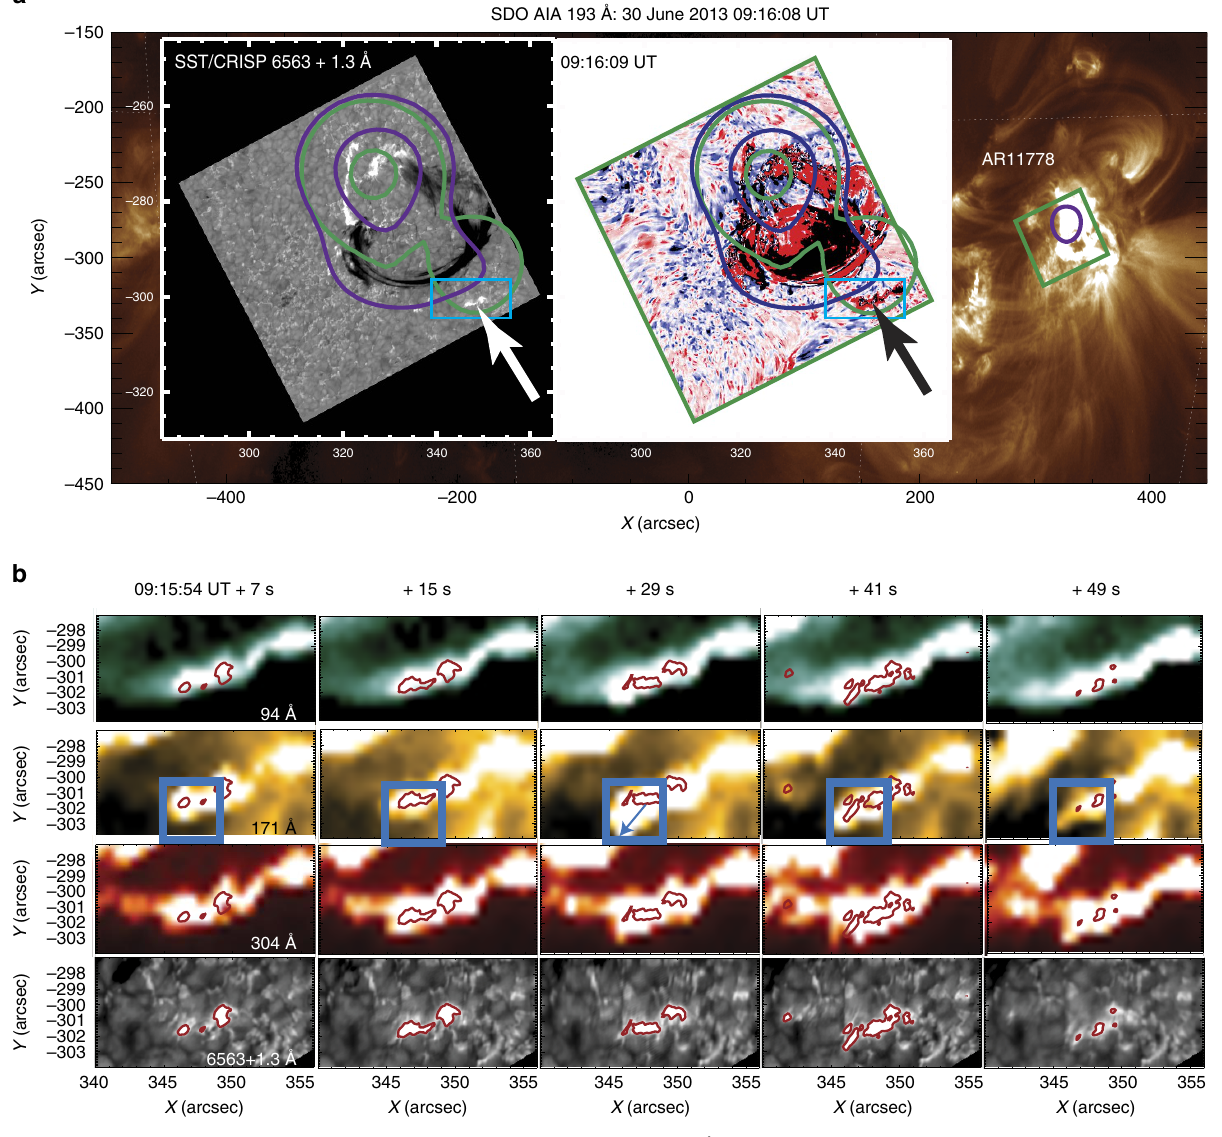
Figure 2 | Observations with AIA. ( a ) A context image for the observation in AIA 193Å overlaid with the CRISP FOV outlined in green within AR11778. Inset left: The co-temporal (09:16:09 UT) CRISP image in the H a line far red wing reveals bright flare ribbons point to by the white arrow for event 2 that are co-spatial within RHESSI imaging contours in 6–12keV (green) and 12–25keV (purple). Inset right: The H a dopplergram for the 33pt. spectral scan per pixel, containing blue/red-shifted motions marked by the relevant colour presented in the range of ± 20kms (cid:2) 1 . The blue boxes in the insets ( a ) highlight the section of the ribbon formation in event 2, which is displayed in b . ( b ) The image sequence describing evolution of the ribbon in the AIA 94, 171 and 304Å channels from top to bottom, respectively. These are co-spatial and co-temporal with the bright ribbon features (contoured in red), in the H a far red-wing images of þ 1.3Å. The 171Å channel reveals a bright jet-like protrusion (within the blue boxed region) that appears to form between the